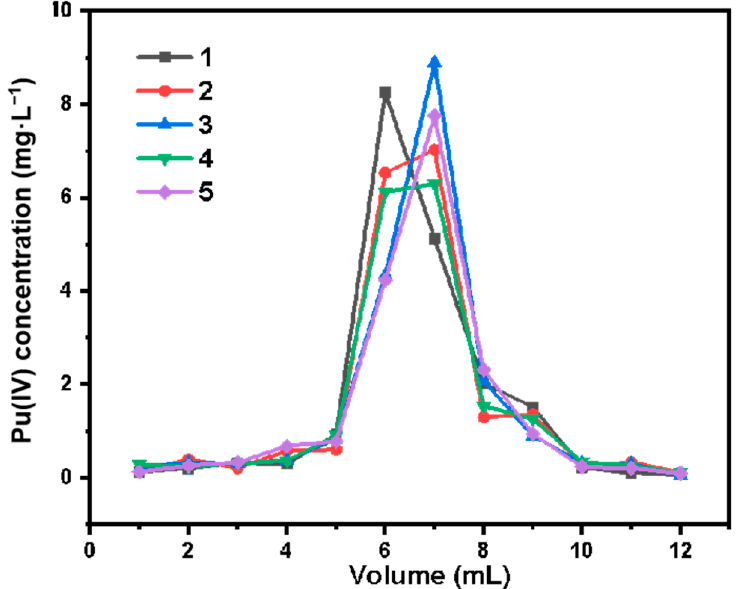
Figure 24. Pu(IV) adsorption-desorption five elution curves on SG-VTS-VPQ column.